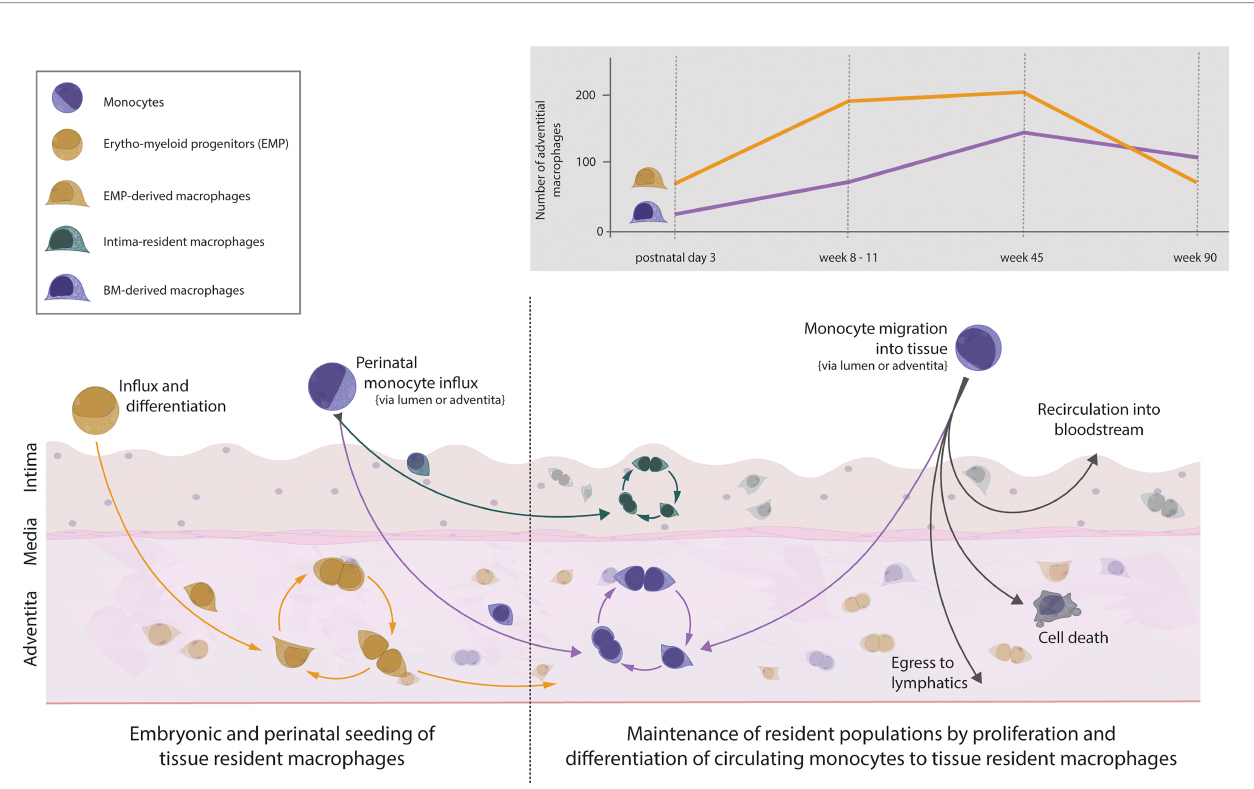
FIGURE 1 | Vascular macrophages and monocytes in the healthy mouse aorta. In fl ux of EMP-derived macrophages into the tissue during embryogenesis starts around embryonic day 9.5. Macrophages settle within the aortic adventitia and sustain solely through local proliferation. Around embryonic day 18.5, monocytes from the bone marrow seed the aorta and differentiate within the adventitia (forming a population of BM-derived tissue resident macrophages) as well as within the intima (forming a separate population of intima-resident macrophages). This recently de fi ned population of intimal macrophages is heavily seeded perinatally but maintains solely through local proliferation. Thus, the adventitia is colonised with macrophages of dual origin which self-sustain numbers through proliferation, and in the case of adventitial BM-derived cells, replenishment from circulating monocytes. The number of cells of different ontogeny varies throughout life, with numbers changing in age adopted from (37). The fate of monocytes migrating into the steady-state aorta follows several possible fates: differentiation into BM-derived macrophages, further migration towards lymphatics, apoptosis, or migration back into